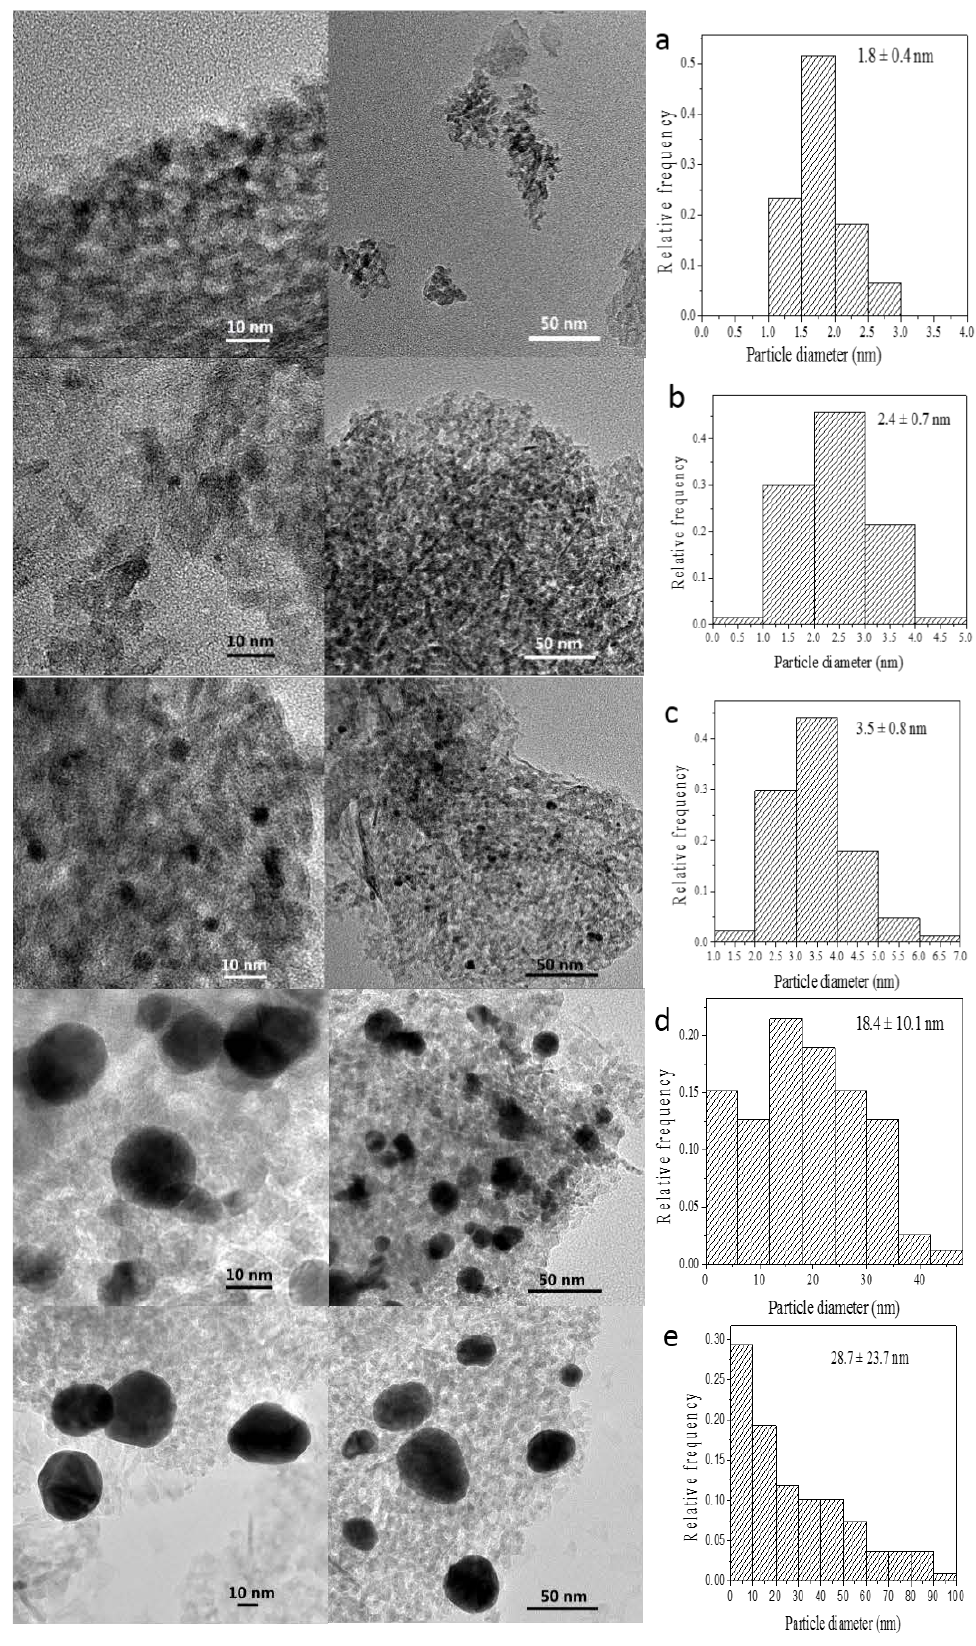
Figure 3. TEM images of ( a ) 0.25 wt % Au/Al 2 O 3 ; ( b ) 0.50 wt % Au/Al 2 O 3 , ( c ) 1.00 wt % Au/Al 2 O 3 ; ( d ) 1.50 wt % Au/Al 2 O 3 and ( e ) 2.00 wt % Au/Al 2 O 3